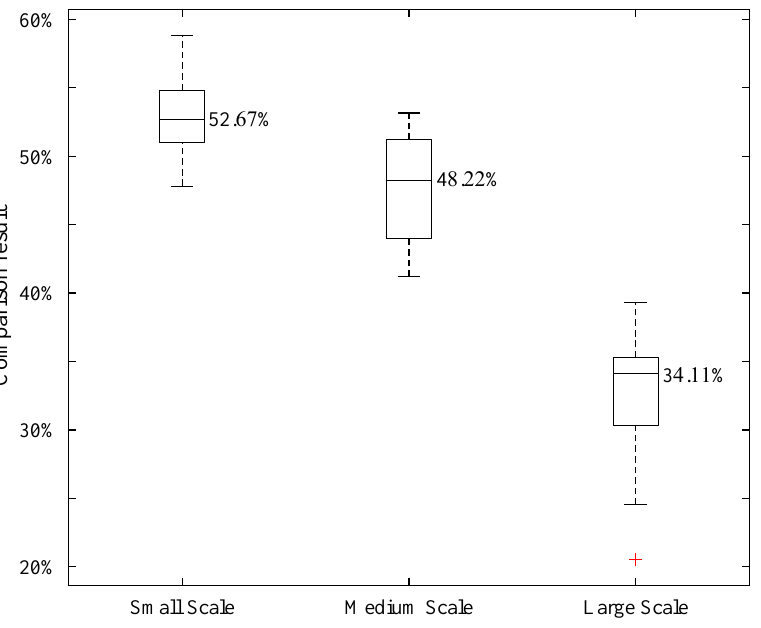
Figure 6. A box plot showing the model comparison results for the three scale